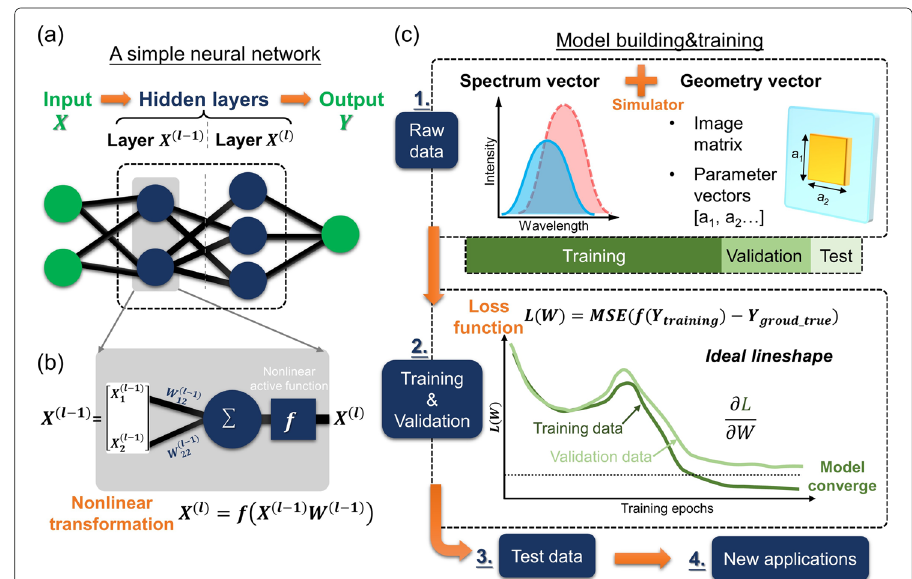
Fig. 4 A neural network (NN) for meta-atoms. (a) A simple structure of NN with an input of X , an output of Y and two hidden layers of X ( l − 1 ) and X ( l ) , respectively. (b) A magnified view of one artificial neuron layer to perform nonlinear transformation from layer X ( l − 1 ) to layer X ( l ) . (c) The set-up and training process of NN-based model for meta-atoms. The procedures are composed of four labeled steps, starting from raw data generation, model training and validation, model test, to new